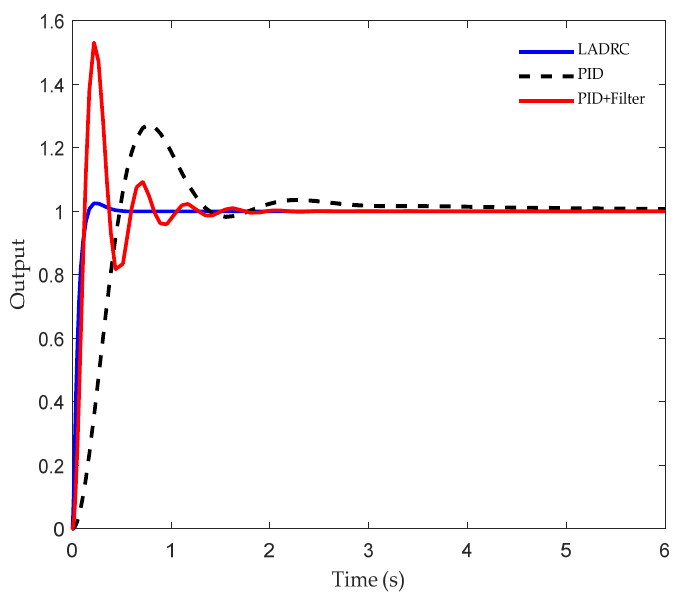
Figure 8. Step response simulation results without disturbance.